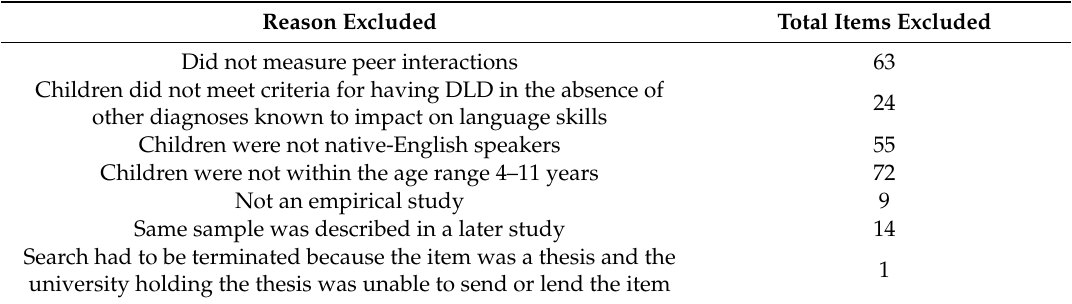
Table 1. Table showing reasons full-text items were excluded from the qualitative